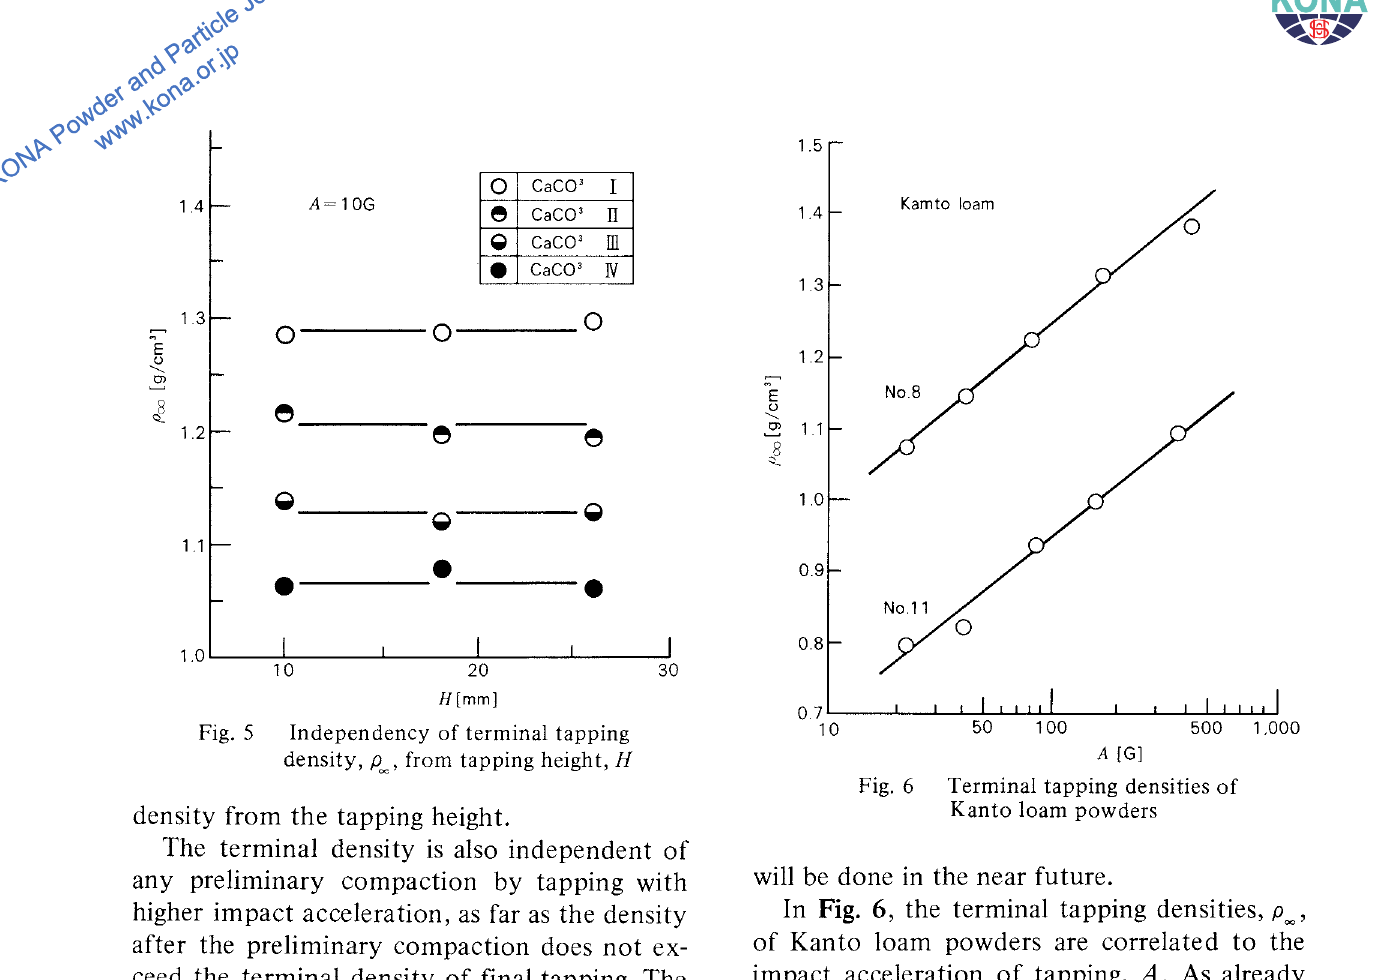
Fig. 6 Terminal tapping densities of Kanto loam